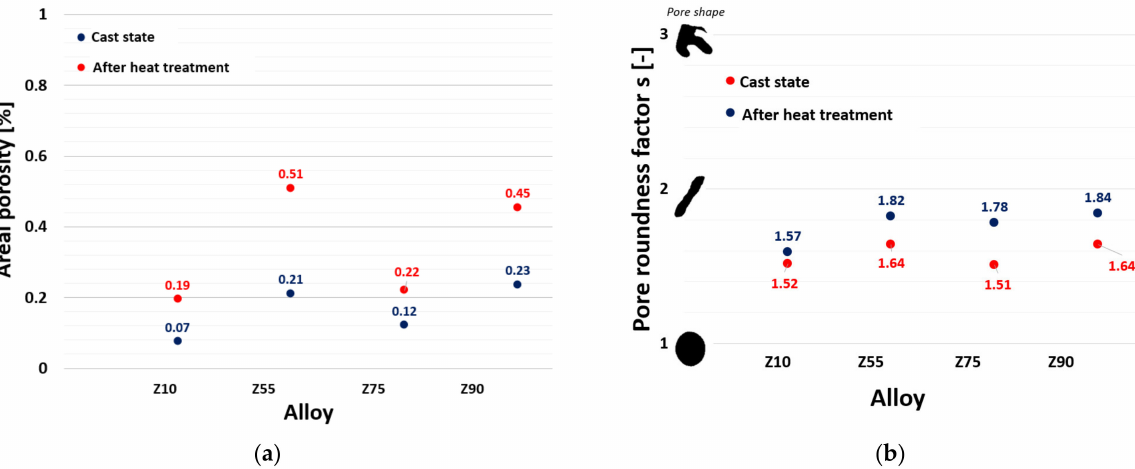
Figure 14. Evaluation of porosity on the B-B cut: ( a ) Areal porosity; ( b ) Pore roundness